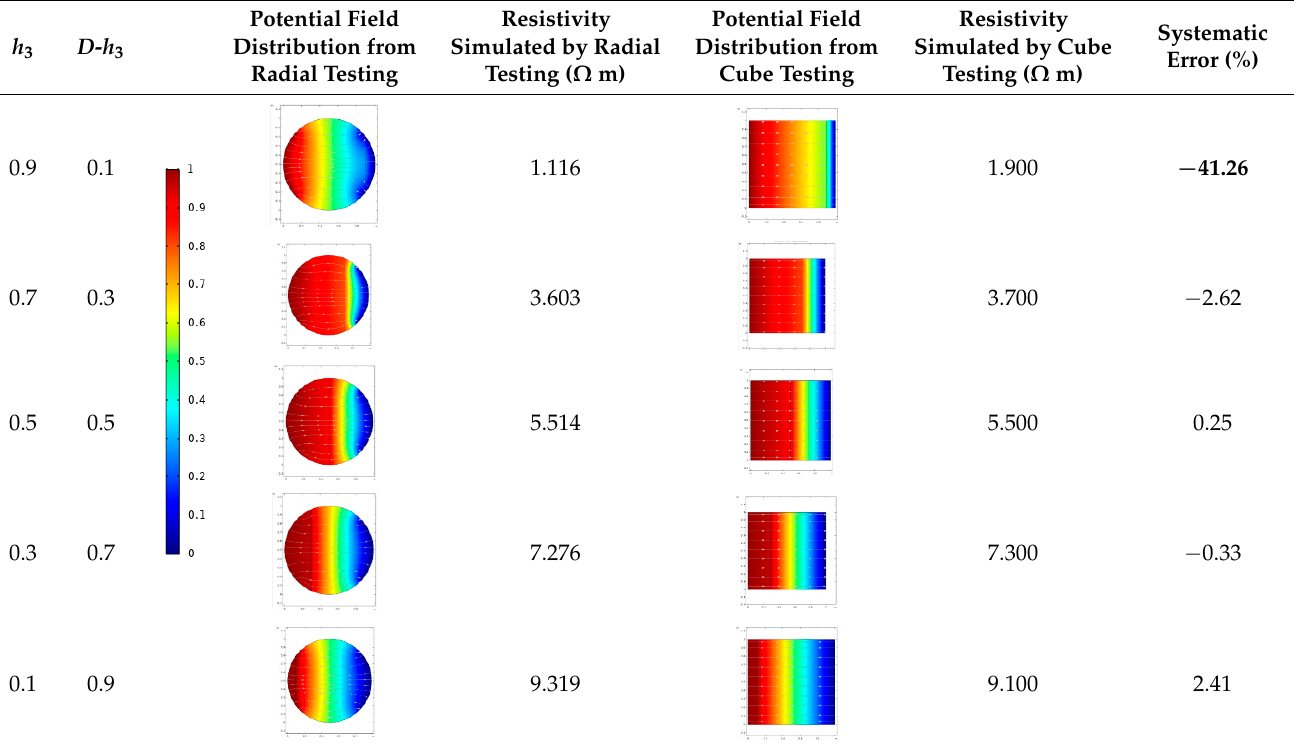
Table 2. Extreme 3: numerical simulation results of different material thicknesses.